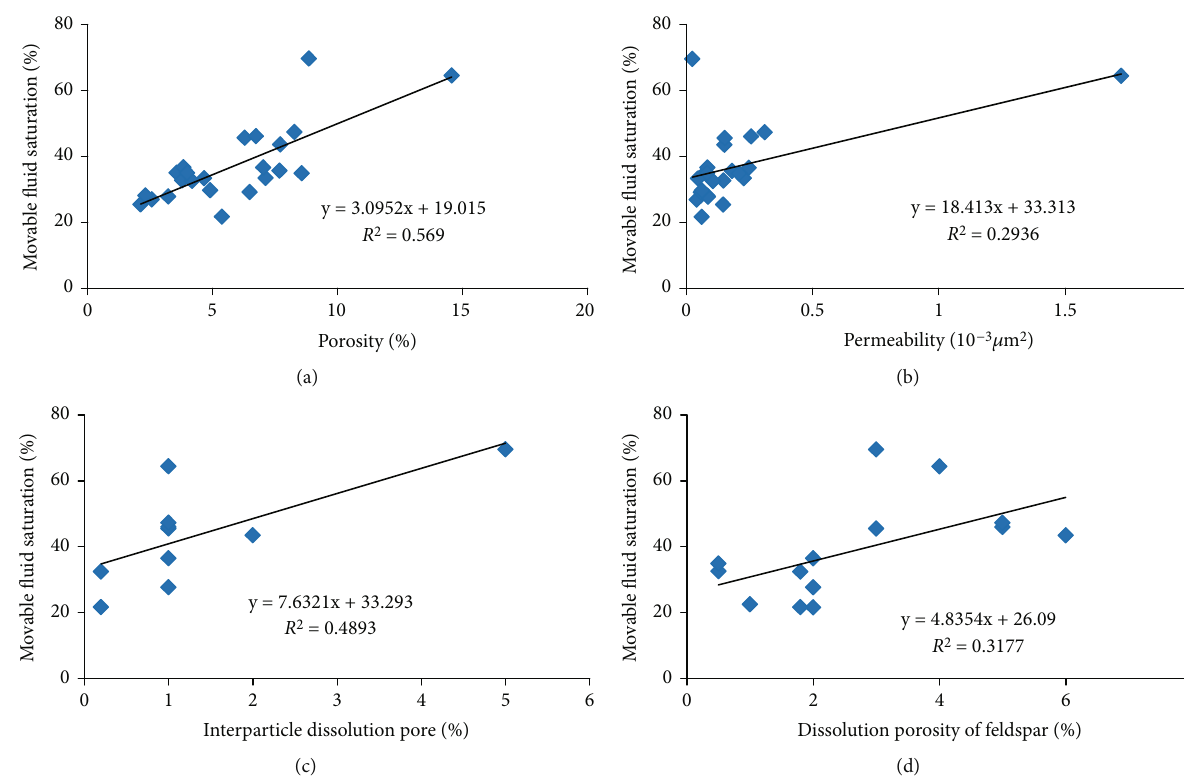
Figure 8: Reservoir physical property, pore type, and movable fl uid